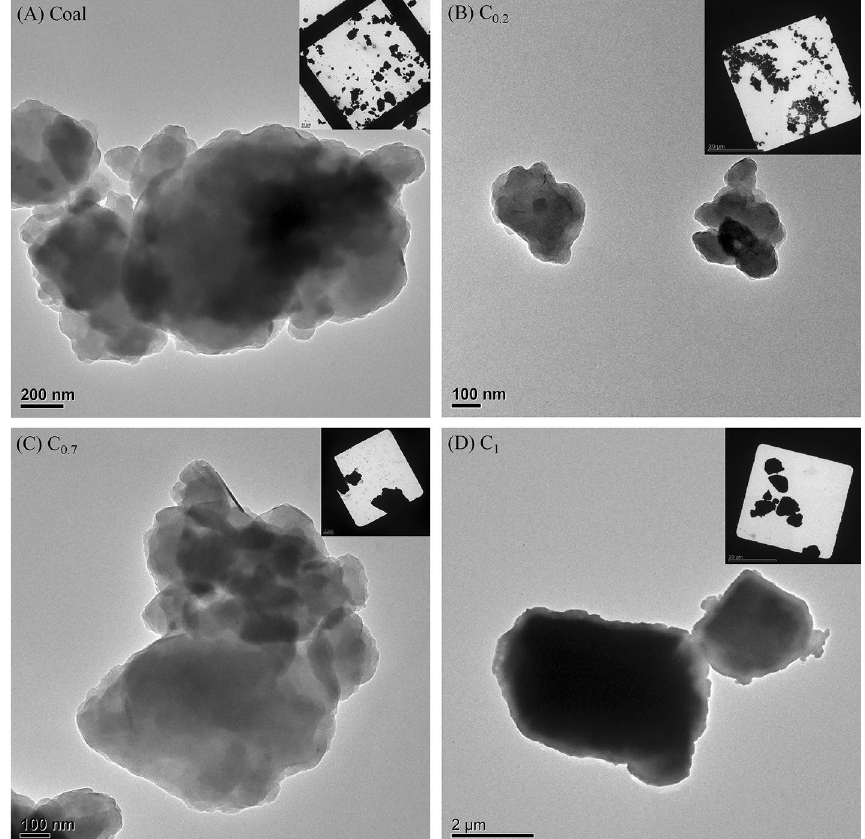
Figure 1. TEM square view and individual particles images. ( A ) Raw coal; ( B ) C 0.2 : coal top layer; ( C ) C 0.7 : coal middle layer; and ( D ) C 1 : coal bottom layer from coal